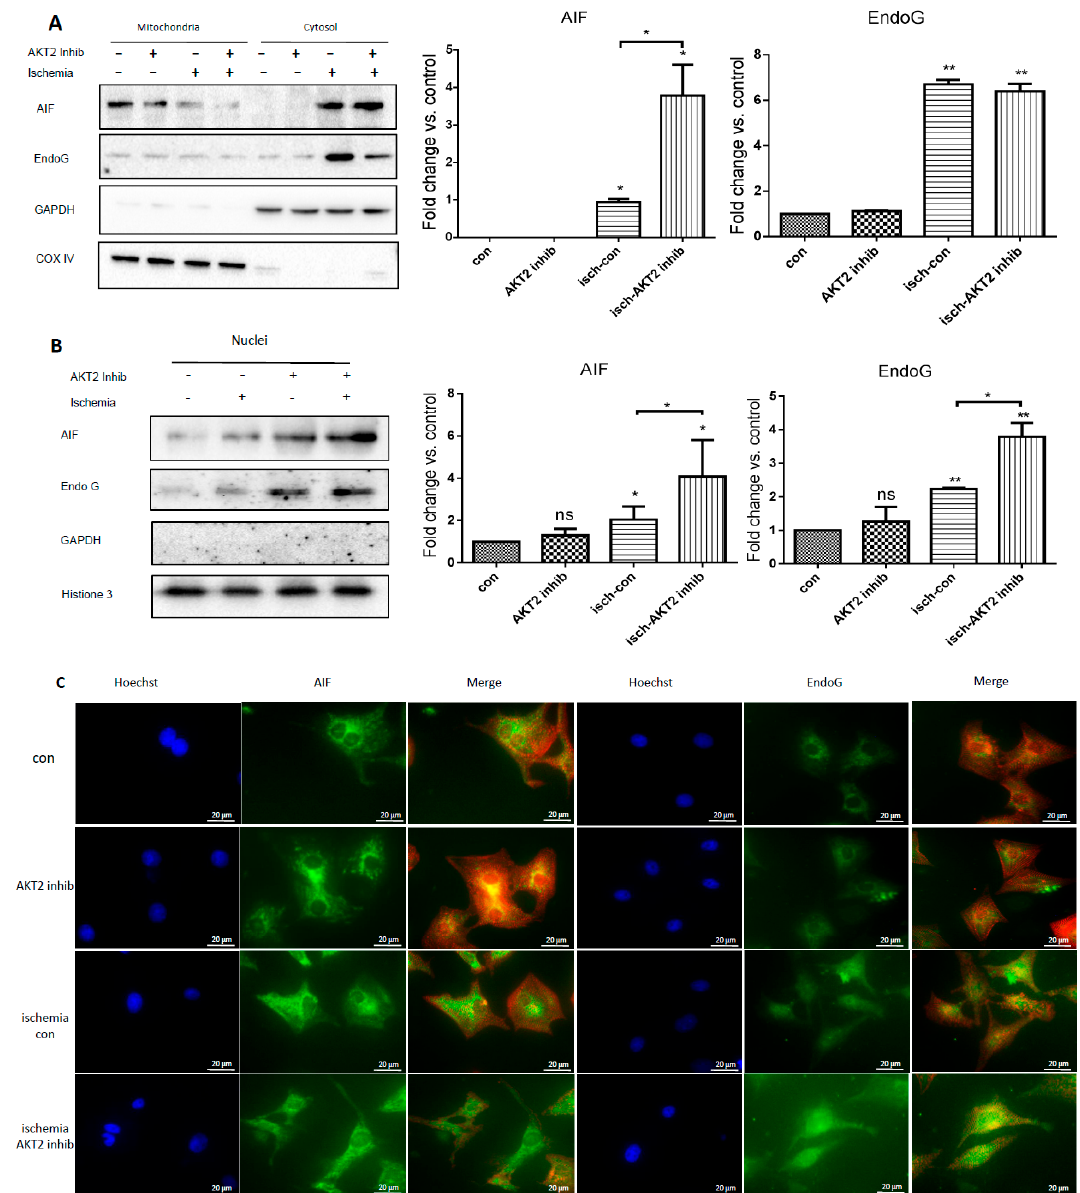
Figure 5. Ischemia induces AIF and EndoG cytosolic and nucleus translocation in cardiomyocytes with AKT2 inhibition. ( A ) left panel: Expression of AIF and EndoG was checked by western blot in cytosolic protein extracts in normal and ischemic cardiomyocytes treated with or without an AKT2 inhibitor; middle and right panel: protein quantification of EndoG and AIF calculated with Image J software; ( B ) left panel: Expression of AIF and EndoG was checked by western blot in nucleus protein extracts in cardiomyocytes with different treatment as in ( A ); middle and right panel: protein quantification of EndoG and AIF calculated with Image J software; ( C ) Immunofluorescence staining of AIF ( green ), EndoG ( green ) and Hoechst ( blue ), α -actinin ( red ), is used as a marker of cardiomyocytes. Scale bar is 20 µ m. Each image in this figure is representative of three independent experiments. The bars represent the mean ± SEM of three independent experiments. * p < 0.05, ** p < 0.01 vs. con; ns: not significant vs. con (one-way ANOVA followed by a Tukey test for post hoc analyses).